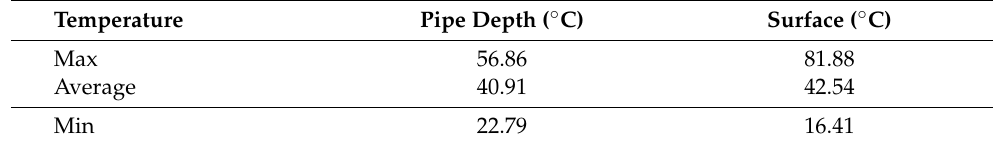
Table 8. Temperature value in the surface of the pavement and in the soil.